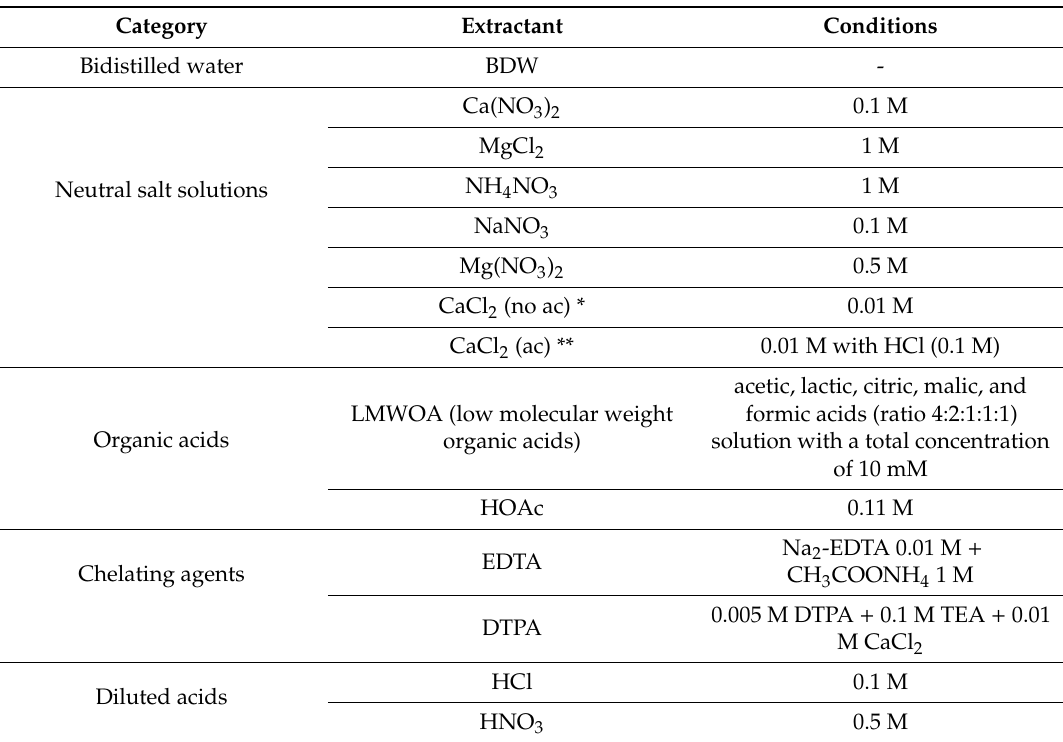
Table 1. Reagents used for the extraction of the bioavailable fraction of Pb in the soil. Category Extractant